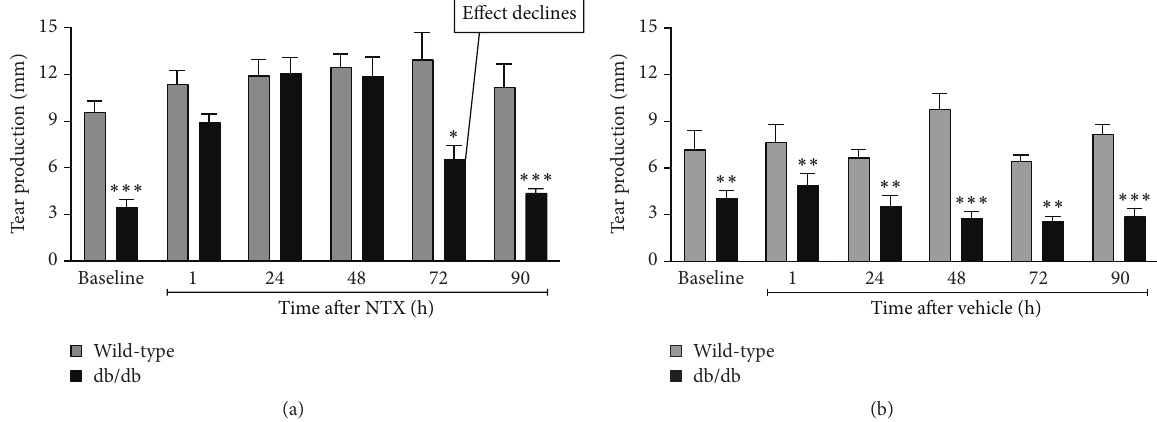
Figure 16: Tear production in wild-type or db/db mice given one drop of 10 −5 M NTX (a) or only vehicle (b). (a) Note the rise in tear production to normal levels with NTX until about 72 hrs after treatment. No effect from vehicle alone (b) with abnormal tear production at all times tested. Ocular surface abnormalities related to type 2 diabetes are reversed by the opioid antagonist naltrexone. Significantly different from measurements for corresponding wild-type mice at each time point at ∗ 𝑃 < 0.05 , ∗∗ 𝑃 < 0.01 , and ∗∗∗ 𝑃 < 0.001 (derived from